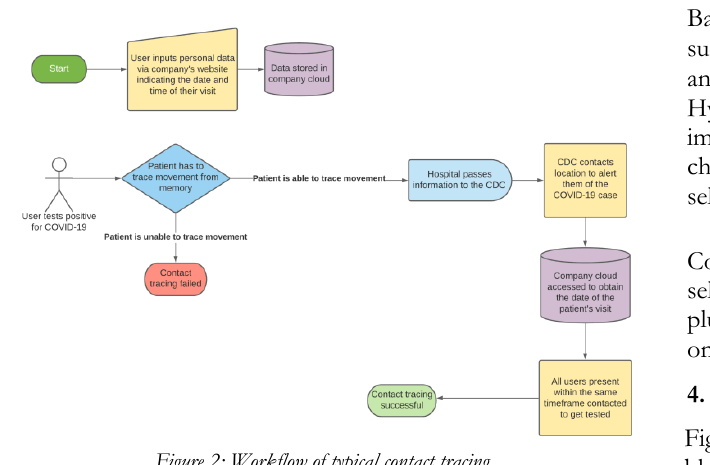
Figure 2: Workflow of typical contact